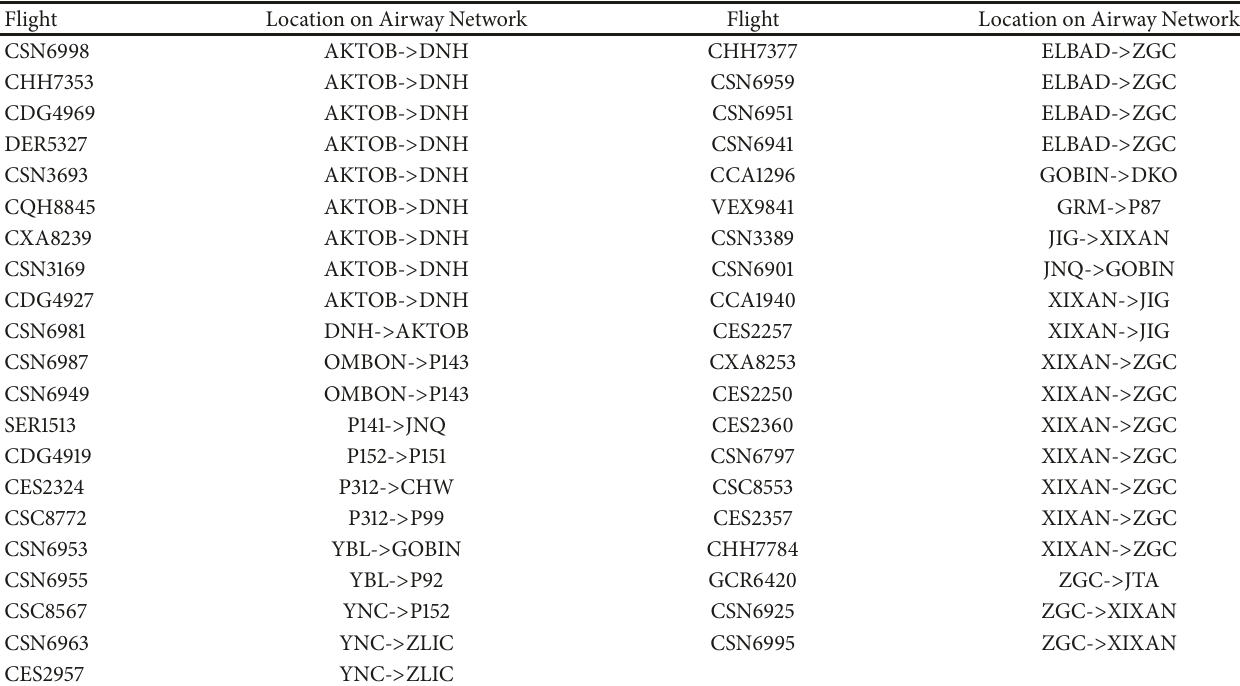
Table 1: The location of the related flights at 12:00 on Lanzhou control